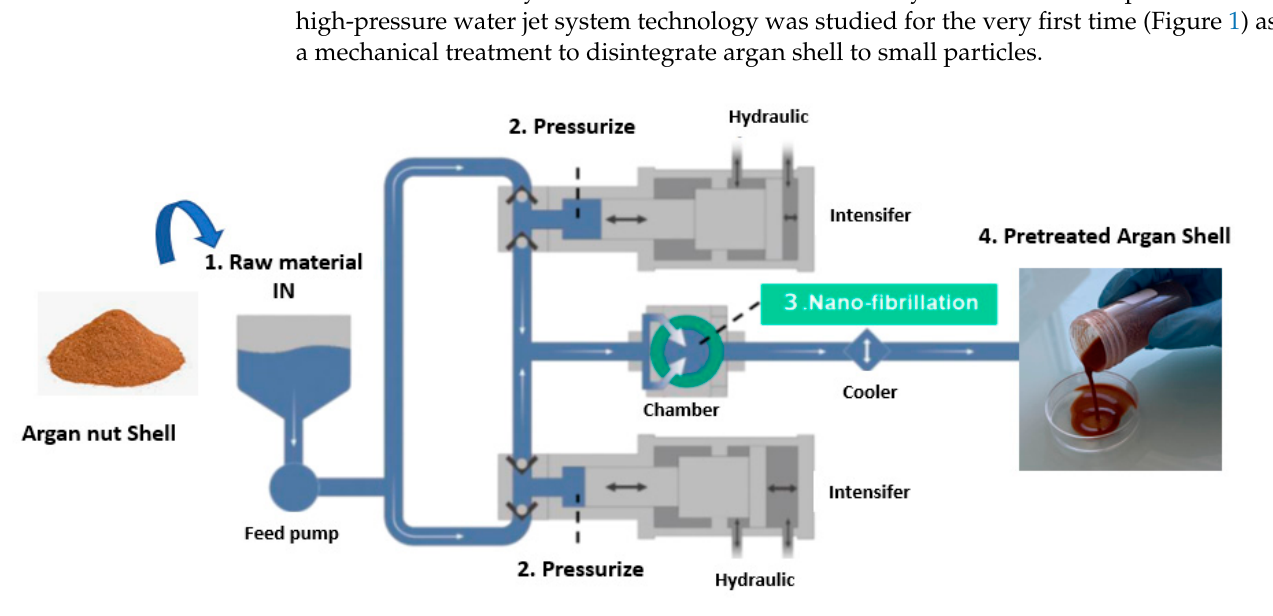
Figure 1. High-pressure water jet system for argan nut shell disintegration.